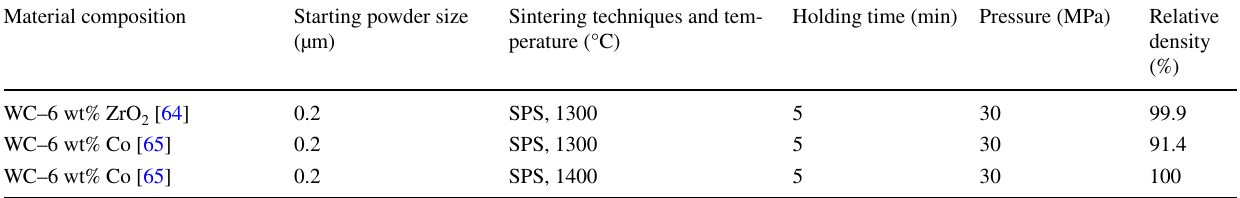
Table 2 Densification data of WC–6 wt% ZrO 2 composites and WC–6 wt% Co cemented carbides sintered via spark plasma sintering (SPS) Material composition Starting powder size Sintering techniques and tem‑ (µm) perature